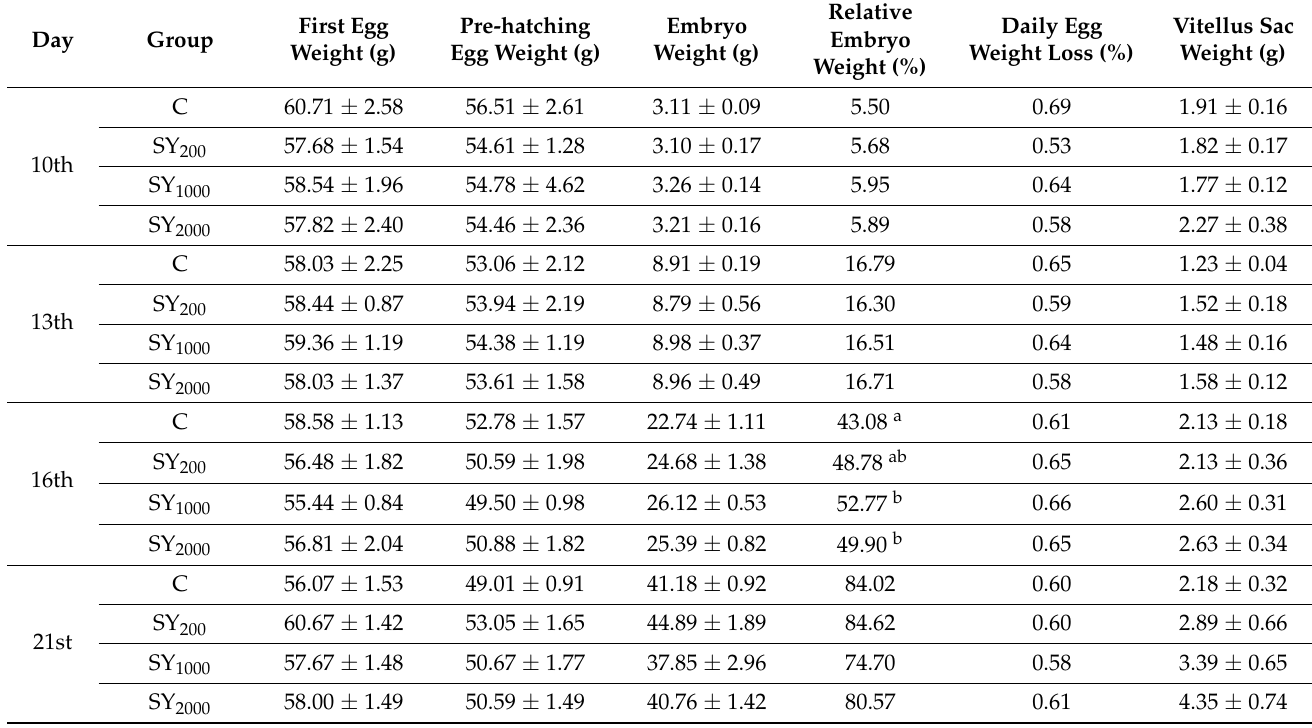
Table 1. Some morphometric values of the embryos used in the study (Mean ±